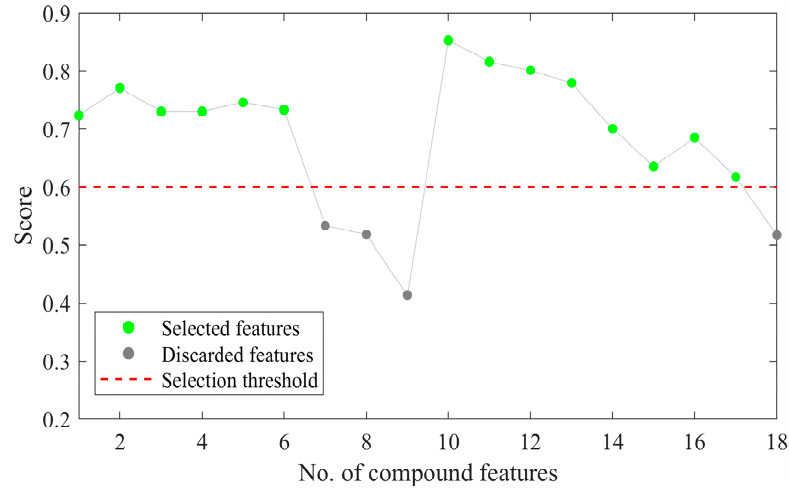
Figure 4. The scores of compound features of bearing 1_3.